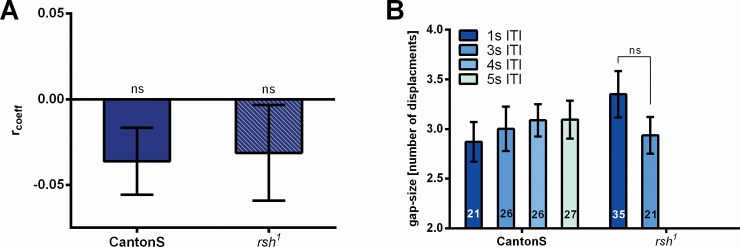
Attention span is not explained by inhibition of return.(A) Neither in CantonS nor in rsh1 (N = 21 and N = 35) a correlation is found between chain length on one side and subsequent number of responses to the other side (and no responses). (B) After a chain of responses to one side, the number of displacements it takes the fly to return with its response polarity to that side, does not depend upon duration of ITIs. Error bars are SEMs (*P < 0.05, **P < 0.01, ***P < 0.001).